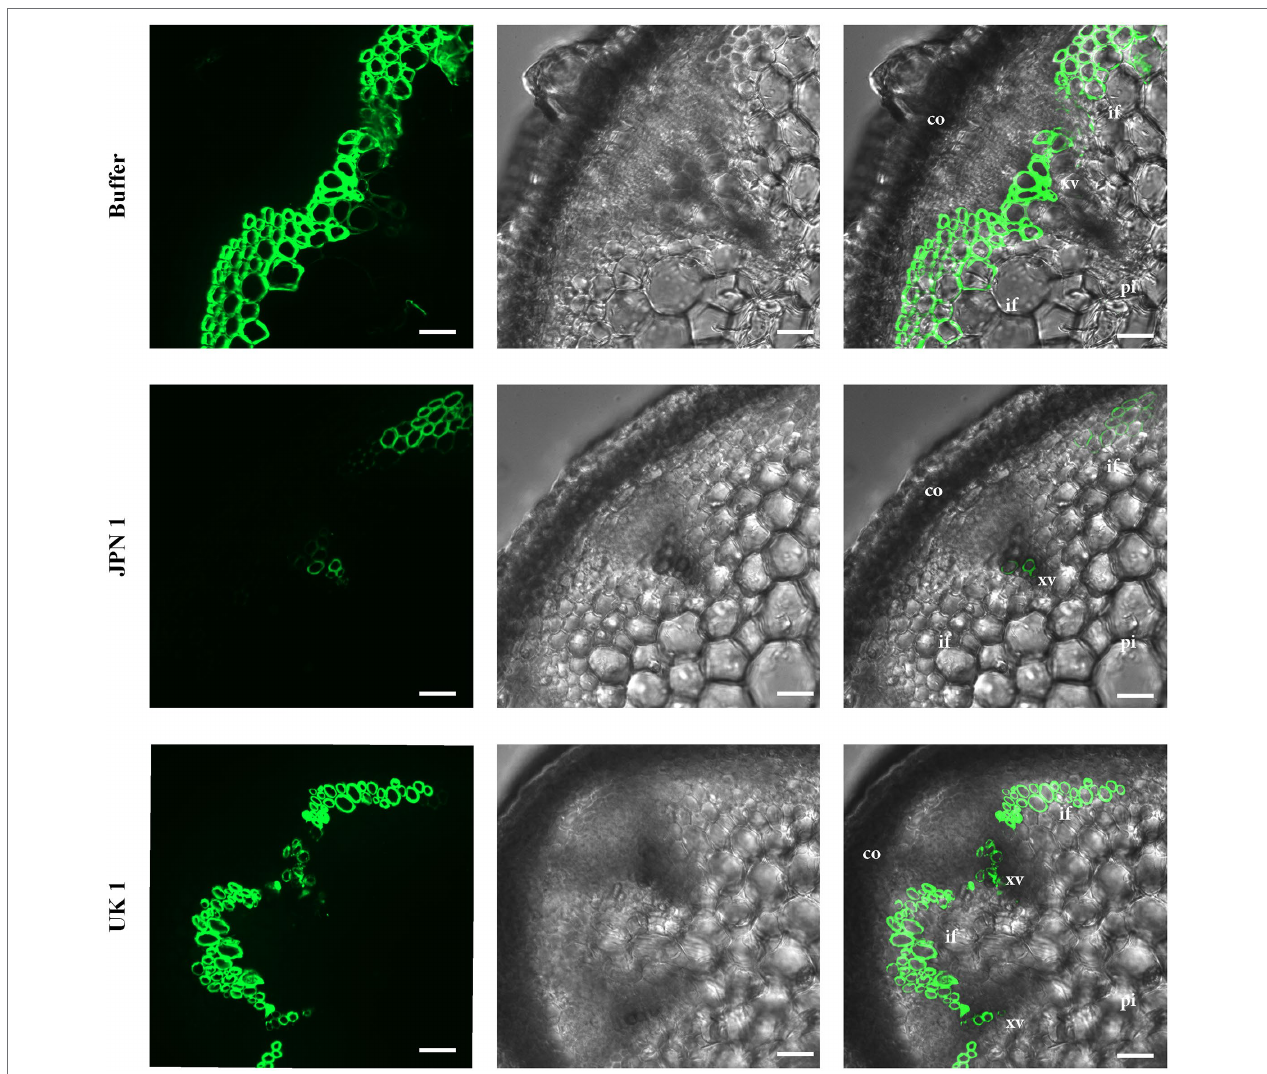
FIGURE 3 | Xylan immunohistochemical analysis. The presence of xylan was revealed by its recognition by the monoclonal antibody LM10, followed by the reaction with a fluorescent secondary antibody. Xylan is only weakly detected in the xylem in TuMV strain JPN 1-infected plants (middle row) compared to buffer control (top) or strain UK 1 (bottom) . In the third column, the fluorescence images are superimposed on the bright field shown in the second column. The cortex (co), xylem vessels (xv), interfascicular fibers (if), and pith (pi) are marked with